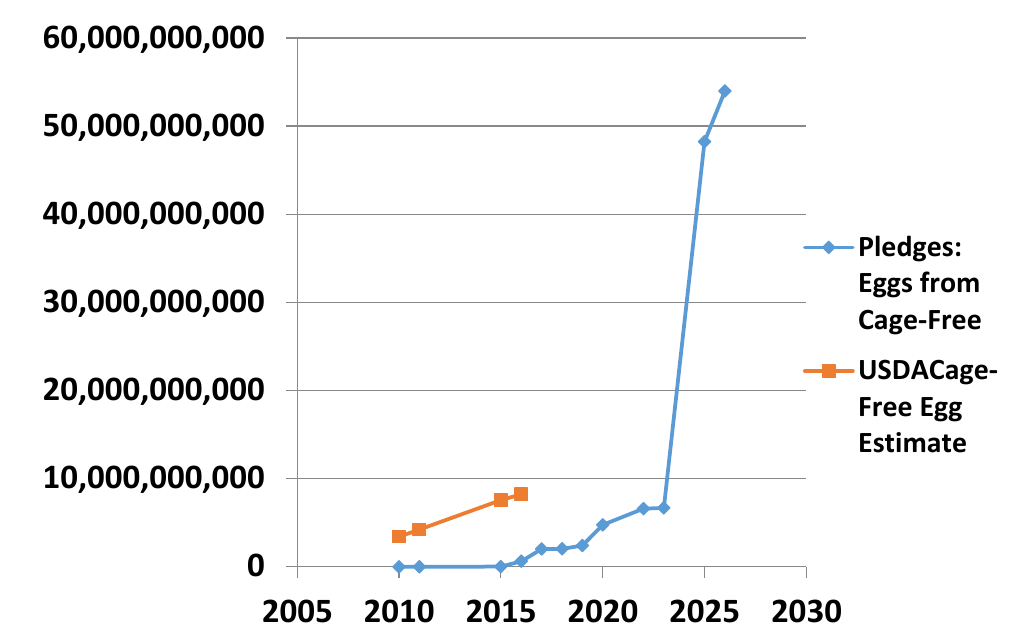
Figure 3. U.S. cage-free egg production: actual and pledged (billions; total U.S. egg production ca. 80 billion [123]). Calculated by year from USDA estimates [83] and company announcement dates provided in Appendix A.